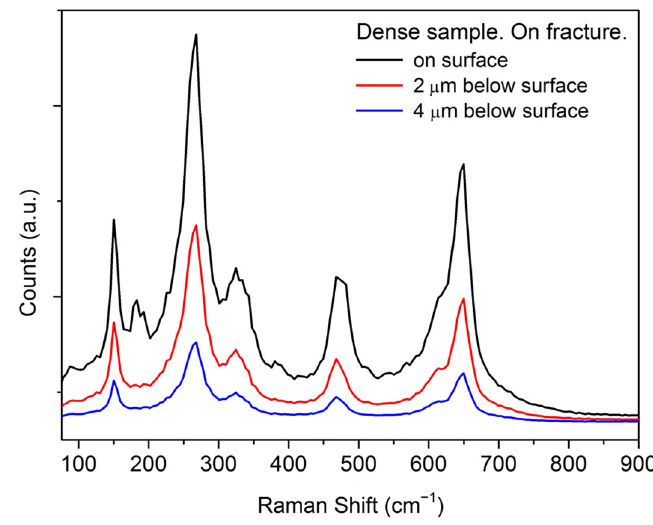
Figure 6. Raman spectra taken with confocal Raman set up on a dense sample. Black line in the surface; red line below surface, stage shifted 2 microns; blue line below surface, stage shifted 4 microns. Measurements with × 100, 0.9 NA objective.